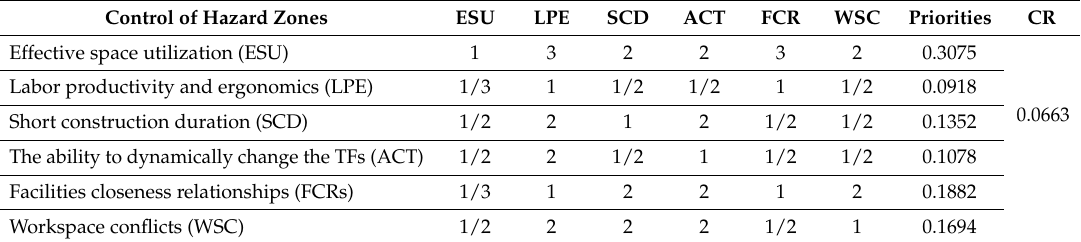
Table 3. Pairwise comparisons of productivity with respect to control of hazard zones.